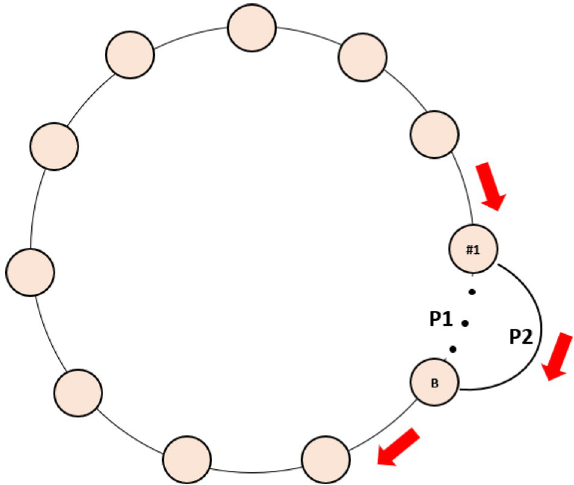
Figure 6. The stepping-stone host metapopulation structure with two ends wrapped around and one extra edge added between Patch #1 and B where patch #1 is the focal patch where disease is initiated. P1 represents the original pathway for disease transmission, while P2 is the pathway though the added edge. All the circles represent patches, the red arrow show the direction of disease transmission among